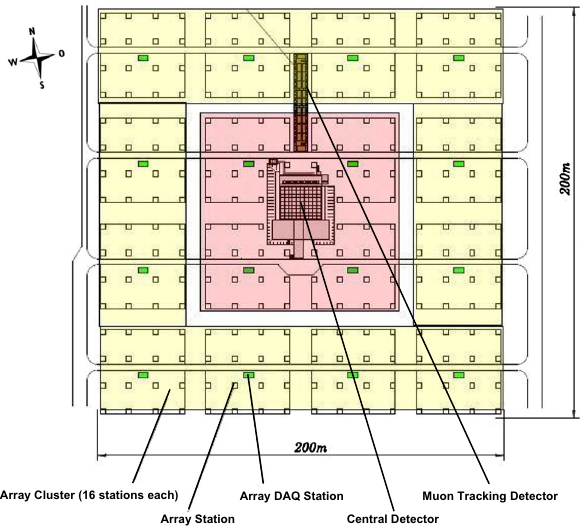
Fig. 3 Layout of the KASCADE array with the underground Muon Tracking Detector and the Central Detector of KASCADE. The red- shaded area indicates the four inner clusters with stations consisting of unshielded liquid scintillation detectors only, whereas the yellow- shaded area displays the outer 12 clusters with stations equipped with unshielded and shielded (muon) detectors